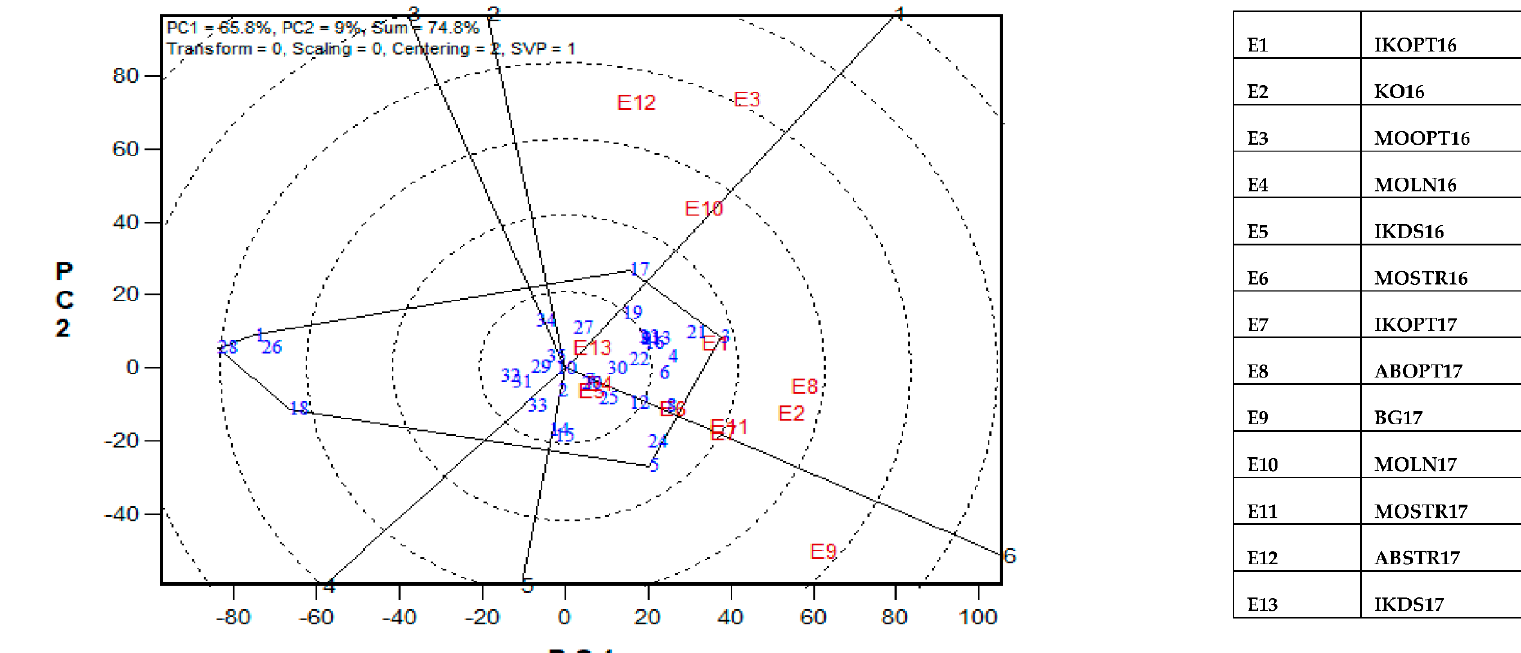
Figure 4. A Which-won where or which-is-best-at-what based on a genotype × environment yield data of 29 early maturing pro-vitamin A hybrids and 6 checks evaluated in 13 environments under drought, low-N, Striga infestation and optimal conditions between 2016 and 2017. The biplot was based on genotype-focused singular value partitioning (‘SVP = 2) and is therefore appropriate for visualizing the relationships among environments. Principal component (PC) 1 and PC 2 explained 74.8% of yield variation.